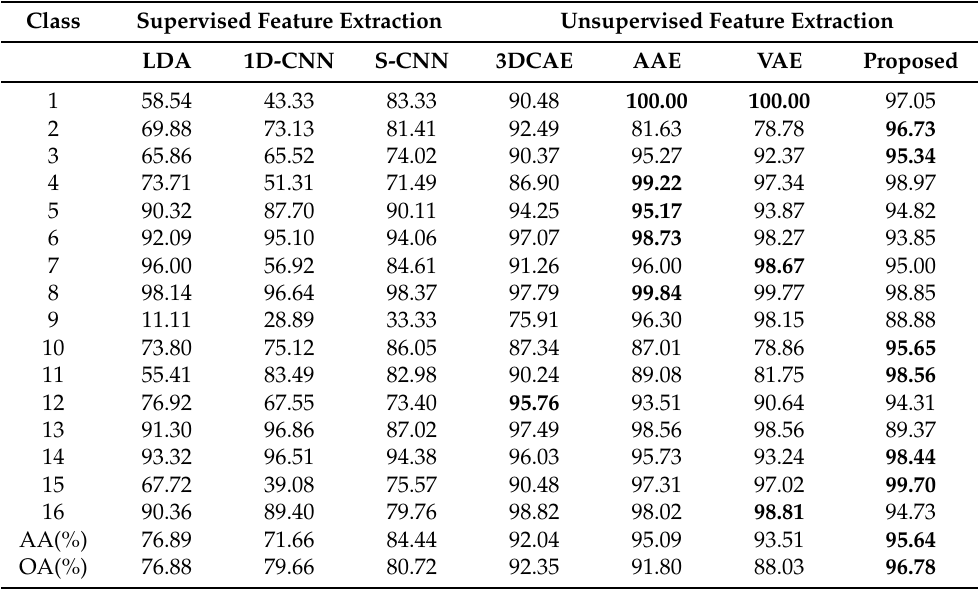
Table 3. Classification results of different models in IP. Some of the data in the table were obtained from [16]. The best values in each row are bolded.